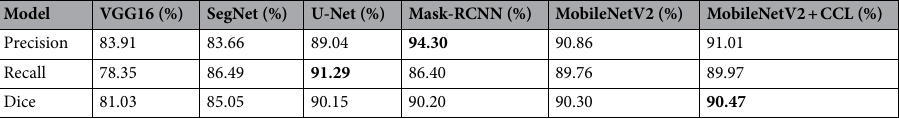
Table 1. The precision, recall, and dice score evaluated using various models on our dataset. Bold values indicate the best performance among the present